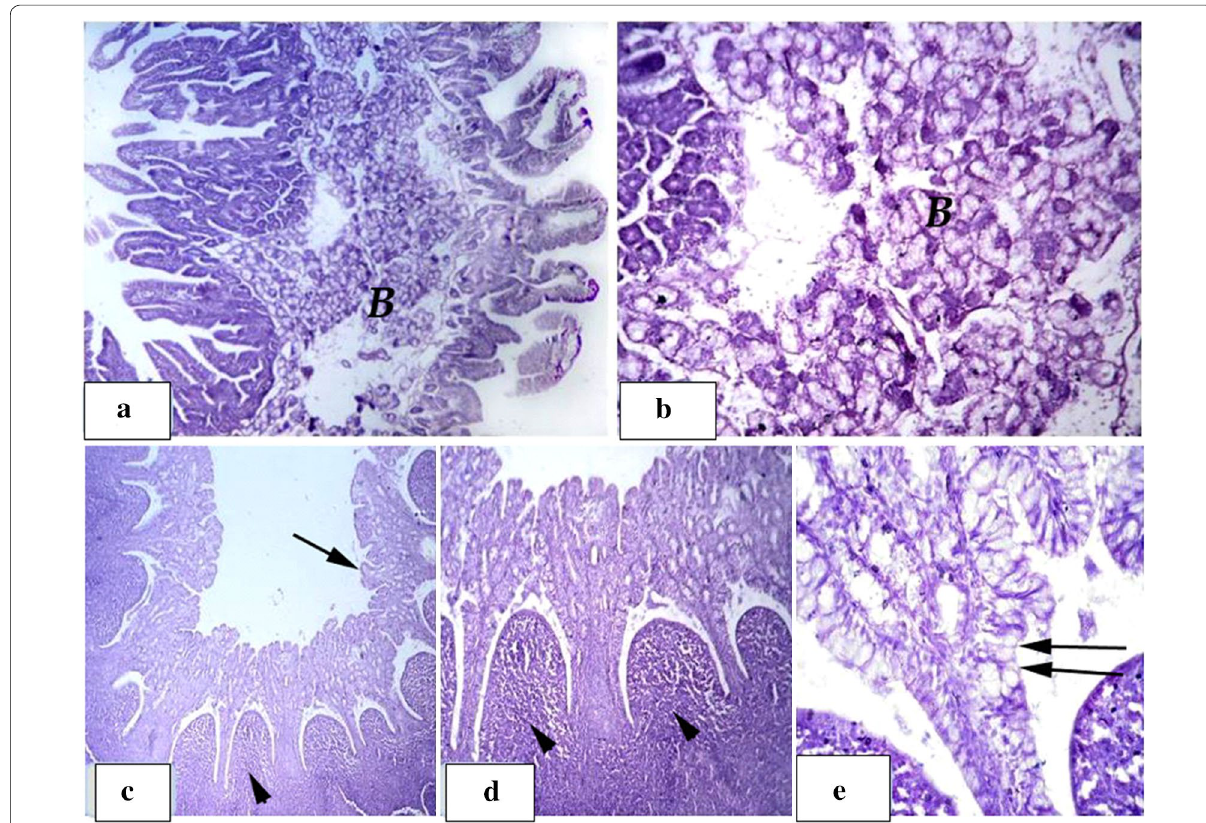
Fig. 4 Group T5: a showing significant development in duodenum wall. b Showing massive layer of mixed brunners gland filling almost of the submucosa. c – e normal, regular and intact lymphatic nodules; peyers patches within the ileum submucosa (arrow head), intact villi (arrow) with increase in goblet lining cells (double